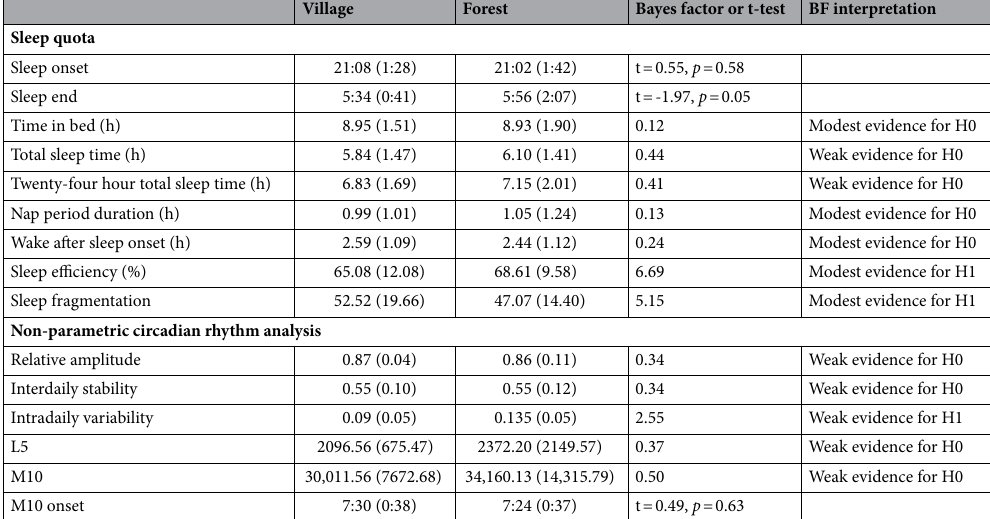
Table 2. Study sample characteristics by village (n = 39 individuals) and forest (n = 23 individuals), including sleep quotas and NPCRA analysis (village = 16 individuals, forest = 15 individuals). Data are presented as mean (standard deviation). Bayes factor is reported to assess differences in sleep quotas between the locations. Time value differences are assessed using t-tests.